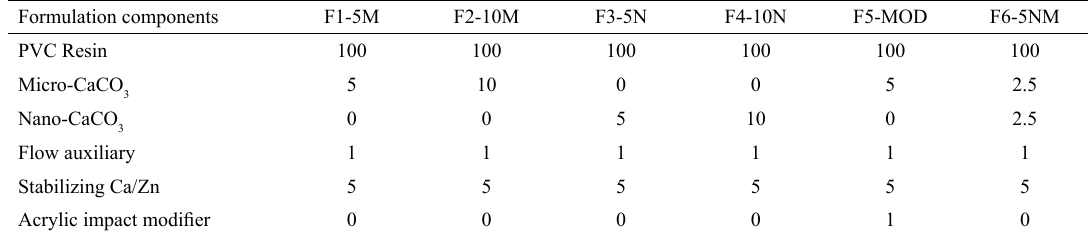
Table 1. Formulation of the PVC compounds (hpr). Formulation